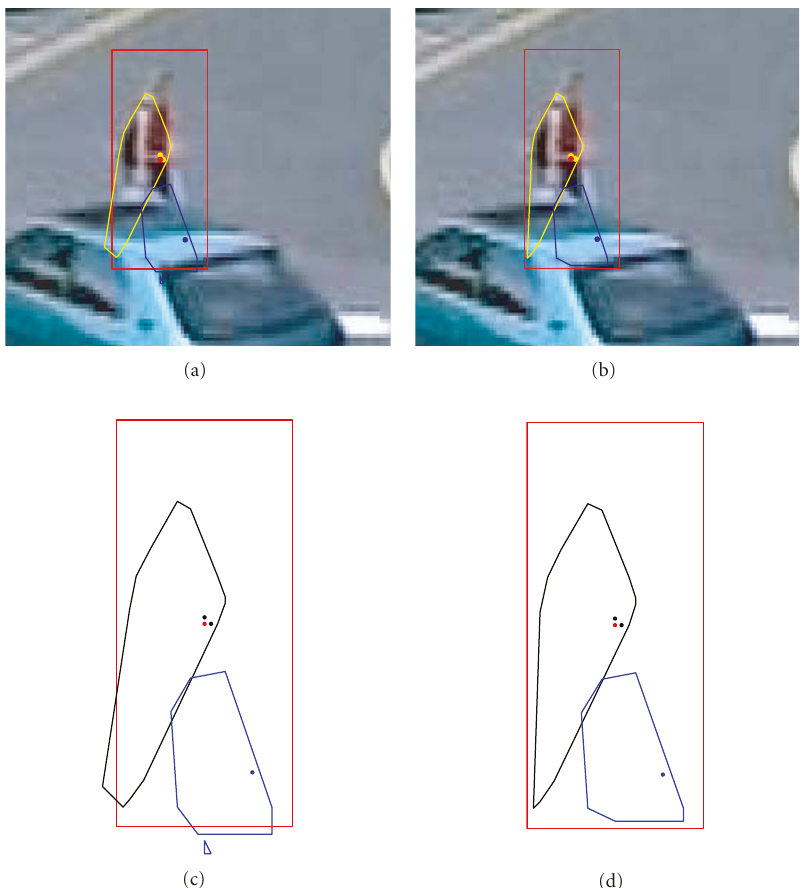
Figure 9: Frame #570 of the sequence appeared in Figures 11(a) and 11(b); the yellow convex: good corners, the blue convex: mixed-good corners, and the red rectangle: bounding box. (a) Classification after voting and (b) classification before updating; there is no malicious corner in this frame; the red point is the winner maximum; the red and yellow points are members of the pool of winners; the blue point is a far maximum; (c) and (d) the same as (a) and (b), respectively, changing the color of the good corners from yellow to black for a better contrast. Note that parts of the classes in (c) are out of the bounding box. They have been updated again (d) to contain the corners of the classes that are present in the Corners